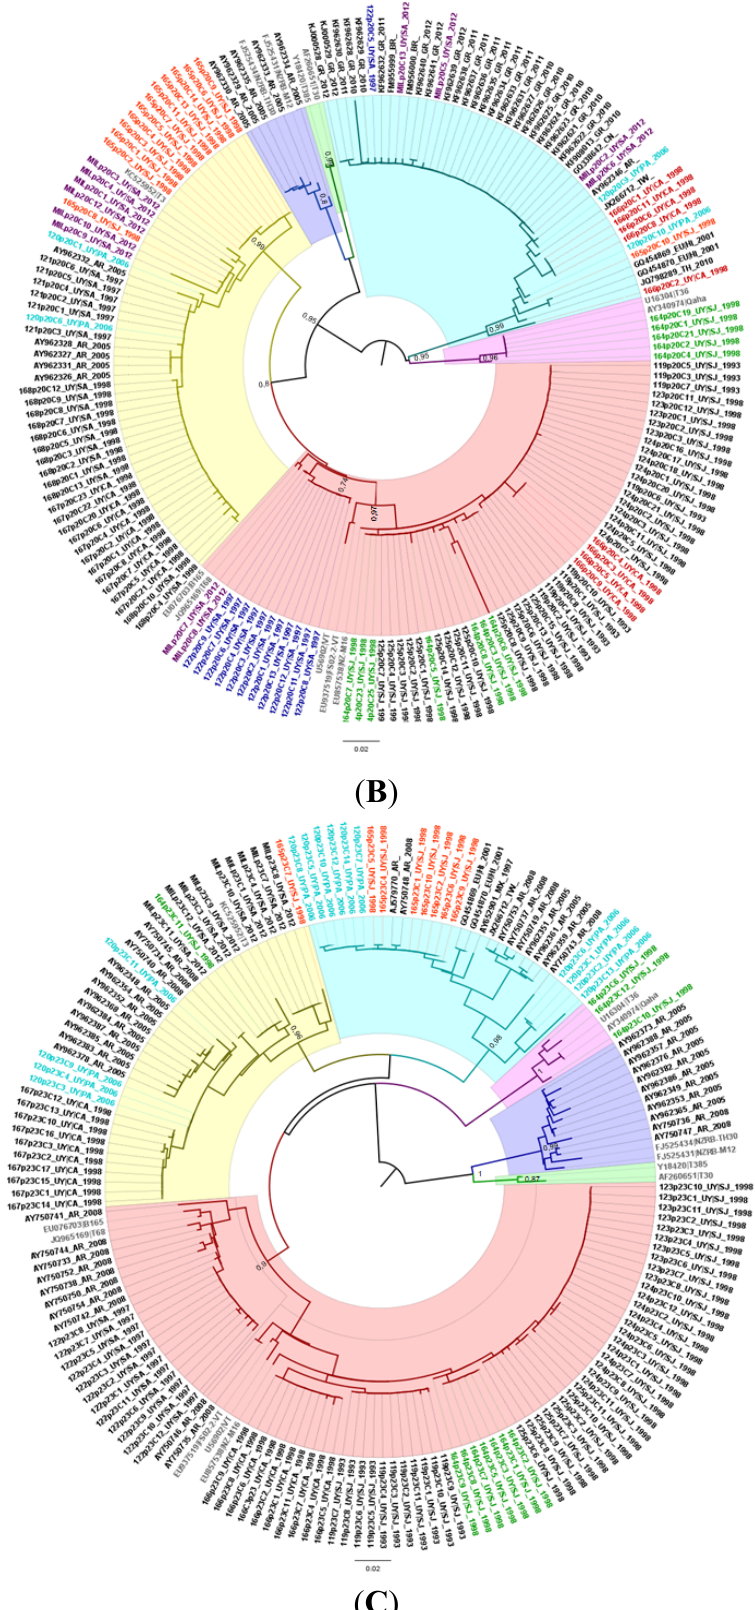
Figure 1. Phylogenetic trees for CTV p25 ( A ), p20 ( B ) and p23 ( C ) genes. Colored and highlighted branches represent genotypes: T30 (green), RB (blue), T36 (violet), VT (red), T3 (yellow) and NC (turquoise). Principal node aLRT values are indicated. Reference strains are marked in grey. Uruguayan samples composed by heterogeneous populations are differentially colored.